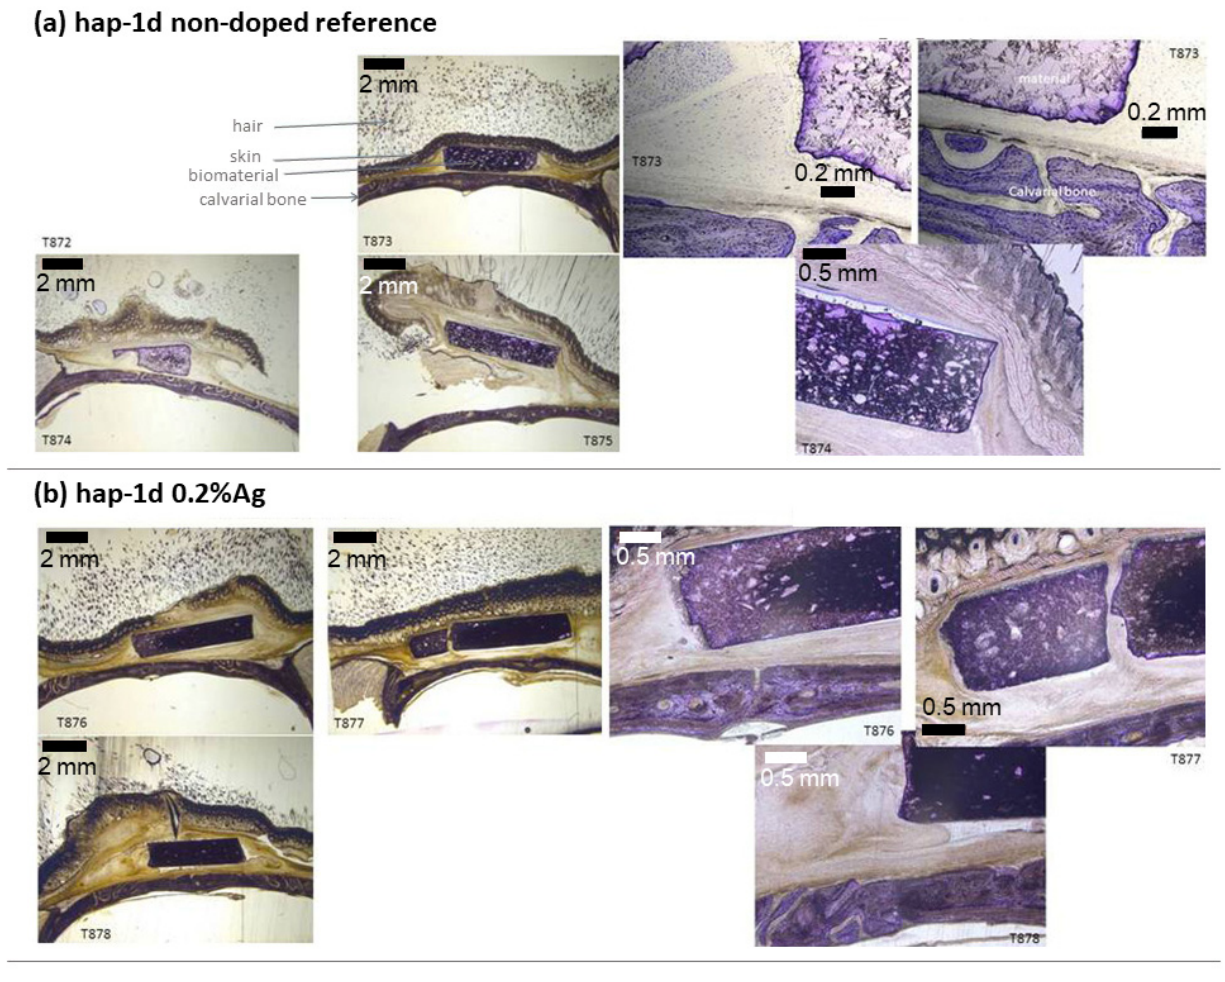
Figure 12. Histological images after implantation of hap-1d, non-doped ( a ), and doped ( b ) with 0.2% Ag. Images on the left provide general views and image on the right side provides higher magnifi- cation.